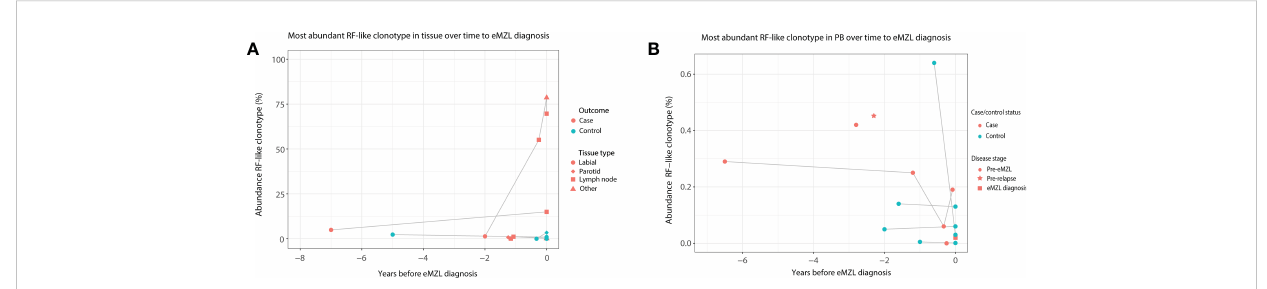
FIGURE 3 Abundance of RF-like clonotypes in cases and controls in tissue and peripheral blood of pSS patients. (A) The abundance (% of total reads in the IG gene repertoire) of the most abundant RF-like clonotype in pSS patients is shown over time until eMZL diagnosis in tissue biopsies in comparison to matched pSS controls. (B) The abundance (% of total reads in the IG gene repertoire) of the most abundant RF-like clonotype in pSS patients is shown over time until eMZL diagnosis in the peripheral blood in comparison to matched pSS